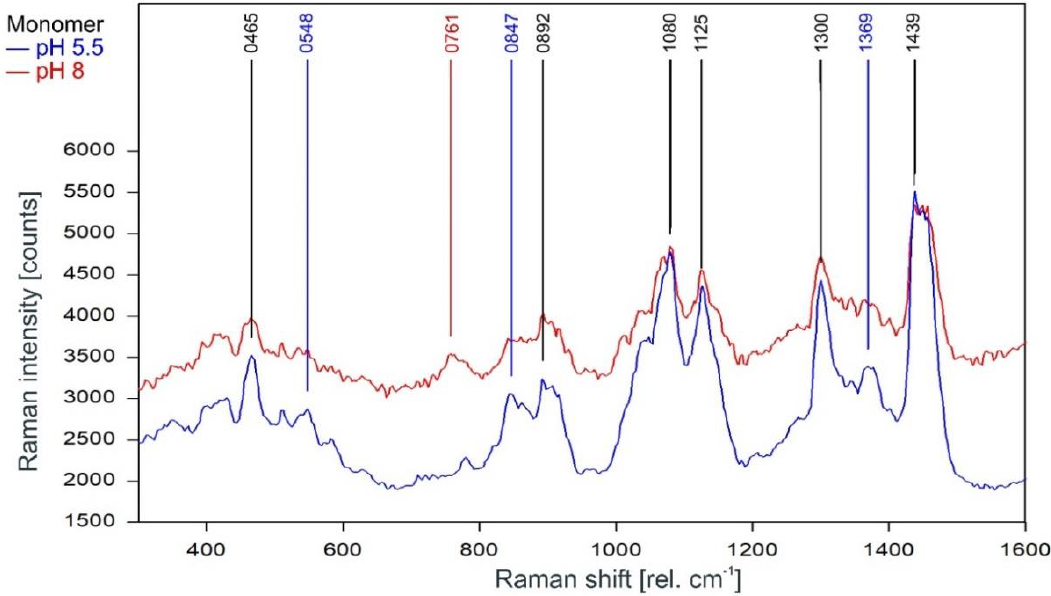
Figure 5. Raman spectrum of KcsA monomer between 300 and 1600 rel. cm−1 at pH 5.5 (blue) and pH 8 (red) as recorded. Raman lines shared by the spectra are marked in black.